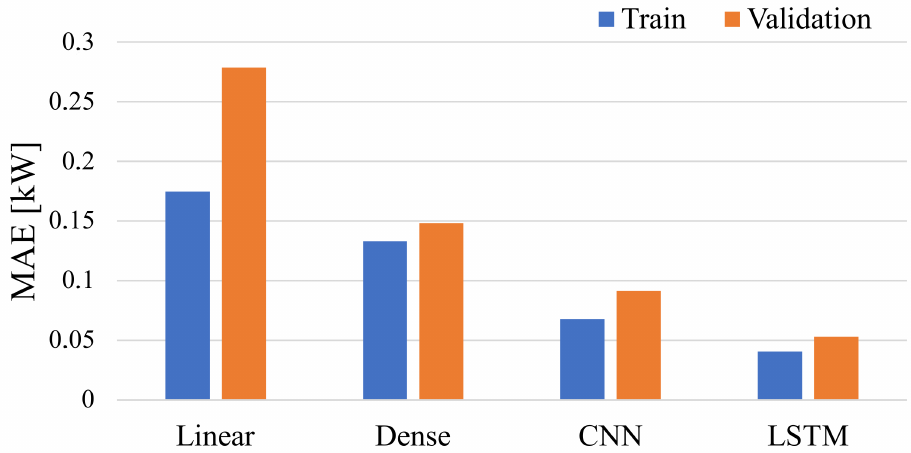
Figure 2. The performance of linear, dense, CNN, and LSTM learning models on the first database in terms of MAE